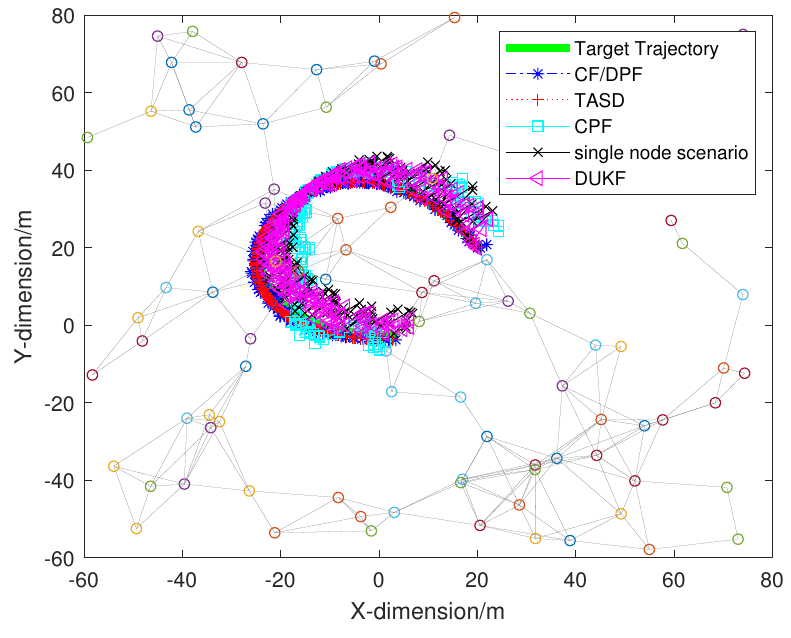
Figure 7. Tracking